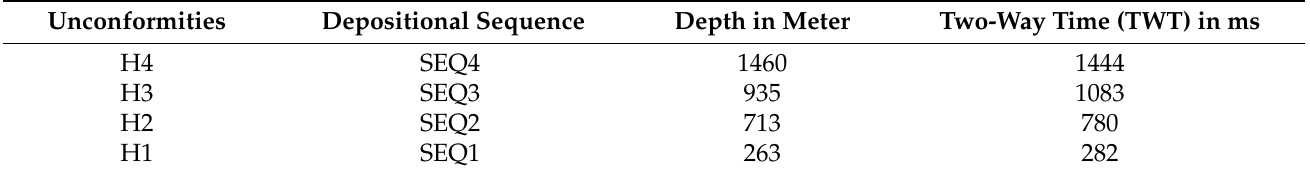
Table 2. Boundaries summary for the depositional sequences of Witiora-1 well.